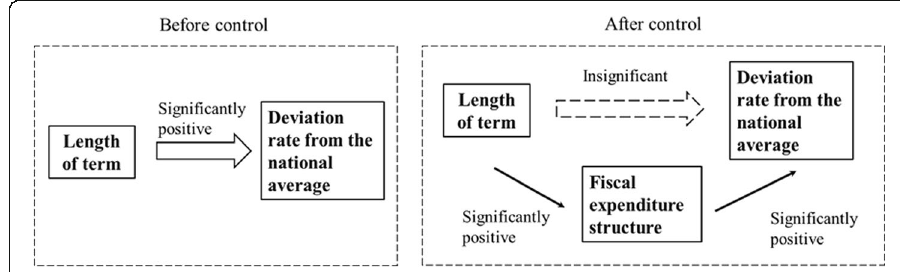
Fig. 5 The impact mechanism of economic construction expenditure